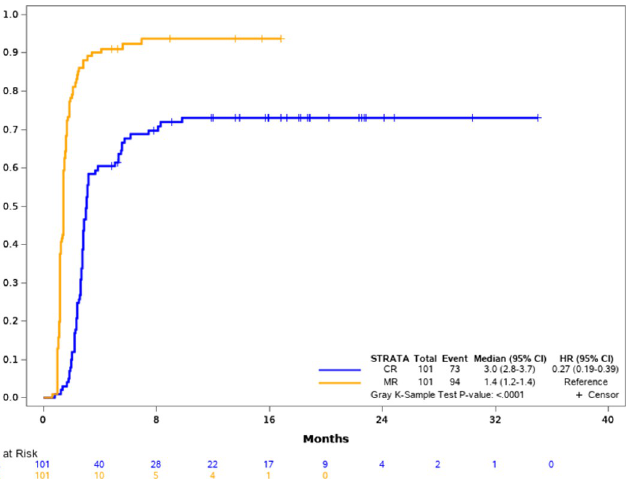
Fig 3. Cumulative incidence analysis of molecular and clinical response. The time to response was estimated; the median time to molecular response was 1.4 months and the median time to clinical response was 3.0